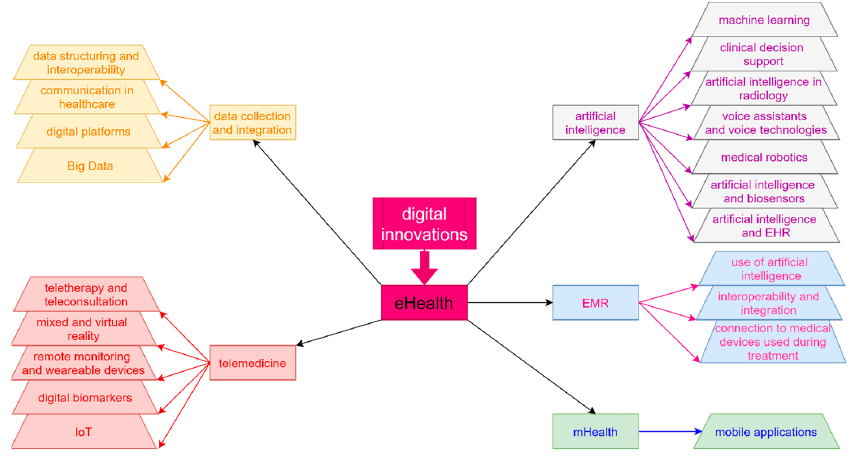
Figure 9. Research directions in publications on digital innovations (IoT (internet of things), AI (artificial intelligence)).